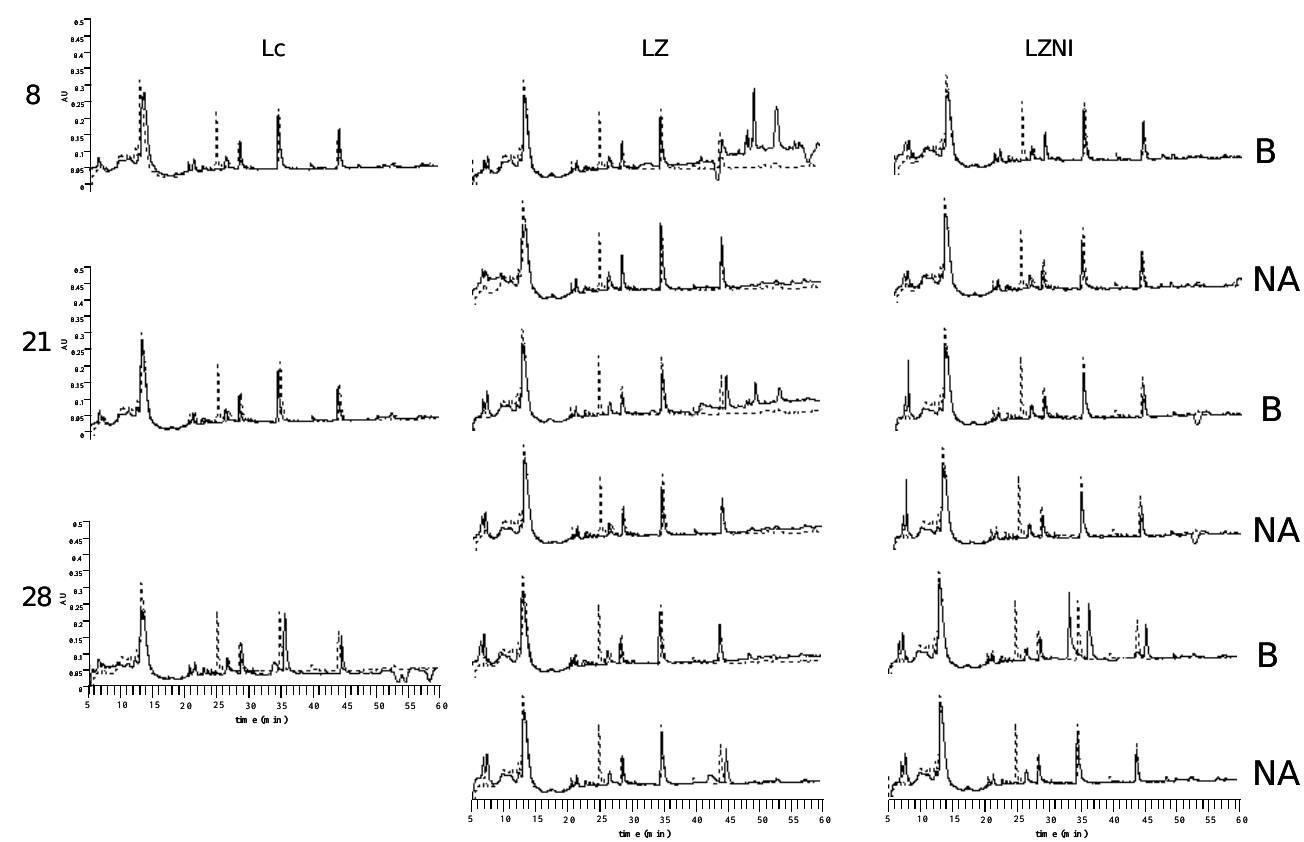
Figure 5. RP-HPLC profiles of Water Soluble Nitrogen (WSN) and pH 4.4 soluble nitrogen in co-cultures of L. plantarum LZ or LZNI with the nisinogenic L. lactis subsp. lactis DSM 20729 (Lc). The time (days) of analysis is indicated on the left. Arrows indicate the peaks that better discriminated between co-cultures of L. plantarum LZ and L. plantarum LZNI. The dashed profile is that of the not inoculated skim milk. B, combination L. plantarum /nisin producer 102:102 CFU mL −1 ; NA, combination L. plantarum /nisin producer 102:104 CFU mL −1 with 10 IU/mL of nisin added.